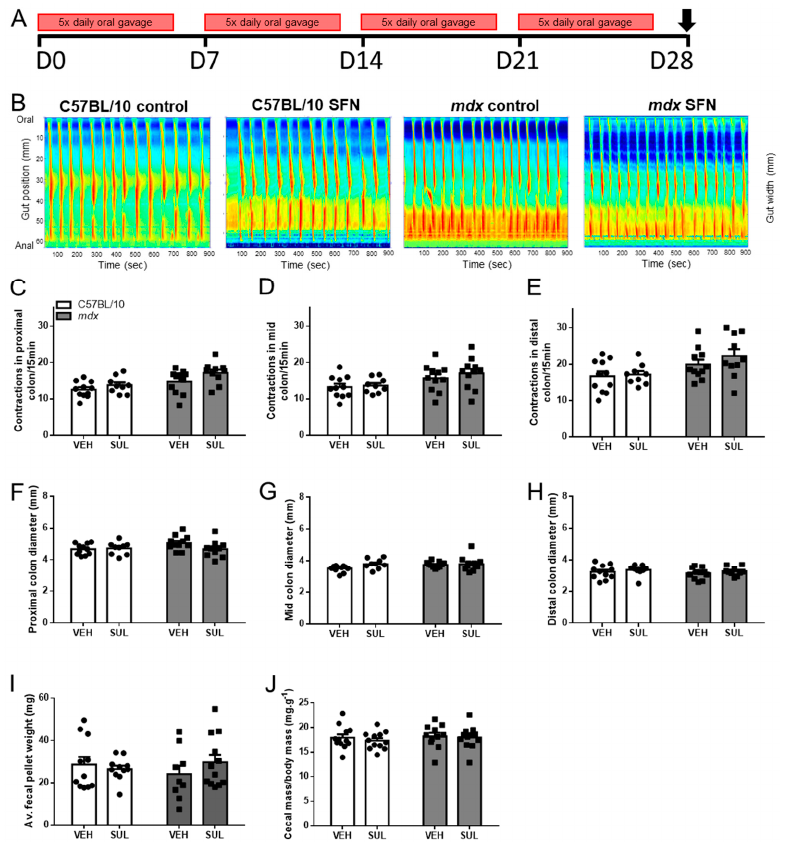
Figure 2. Oral SFN administration does not improve gastrointestinal function in mdx mice. ( A ) Four-week-old male C57BL/10 and mdx mice received either vehicle (2% DMSO/corn oil; VEH) or SFN (2 mg/kg in 2% DMSO/corn oil; SFN)